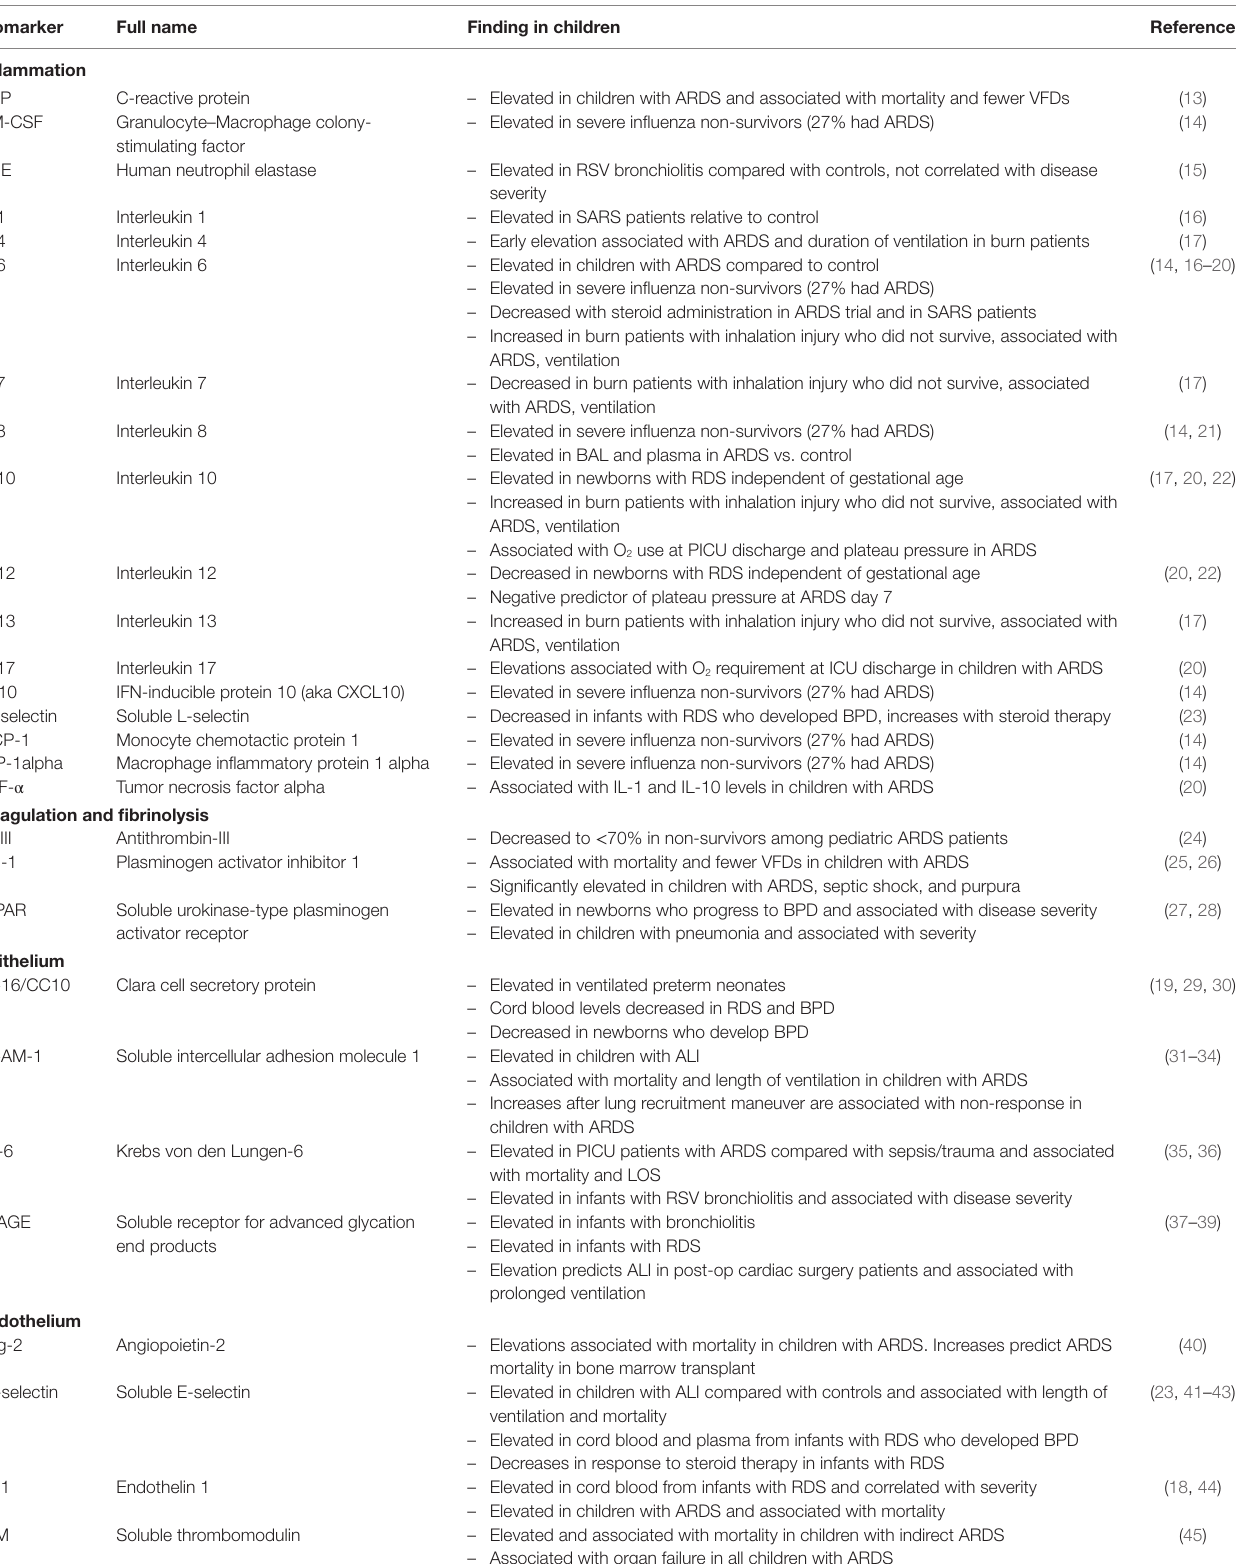
TABLe 1 | Serum/plasma